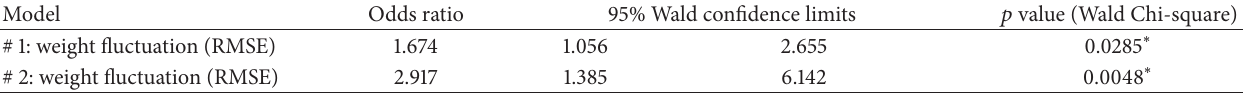
Table 2: The association between weight fluctuation and postmenopausal breast